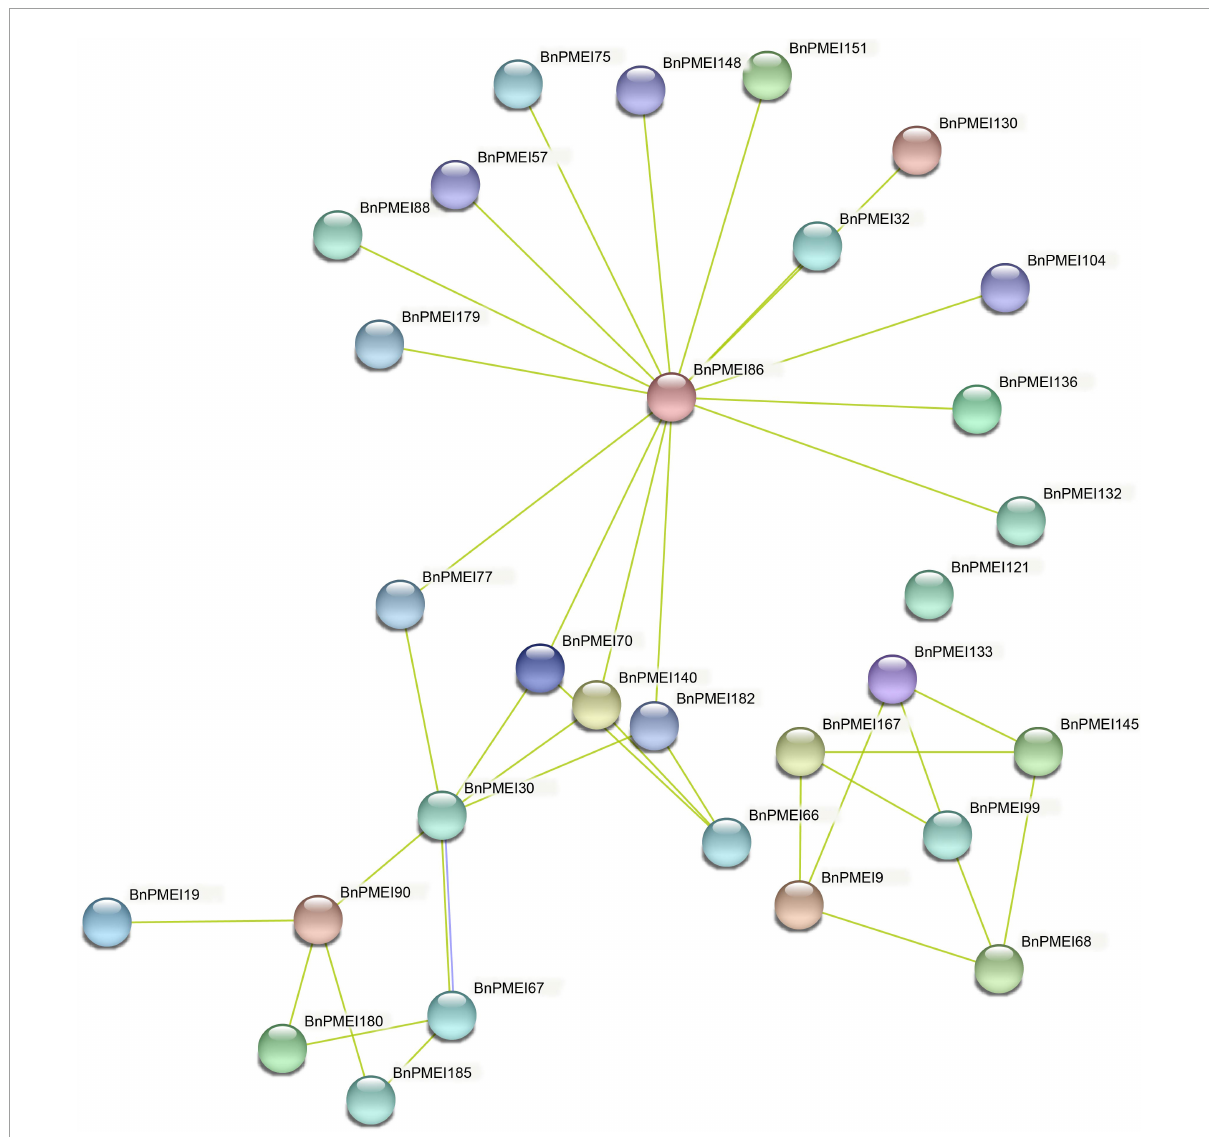
FIGURE9 Protein–protein interaction networks of BnPMEIs. The networks were generated from the STRING database. Network nodes represented BnPMEI proteins. Edges represented protein-protein